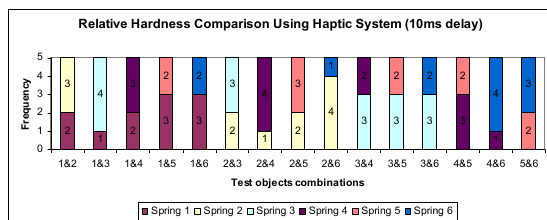
Fig. 11. Relative hardness comparison of the six test objects through the master-slave haptic gripper system (5ms time delay).